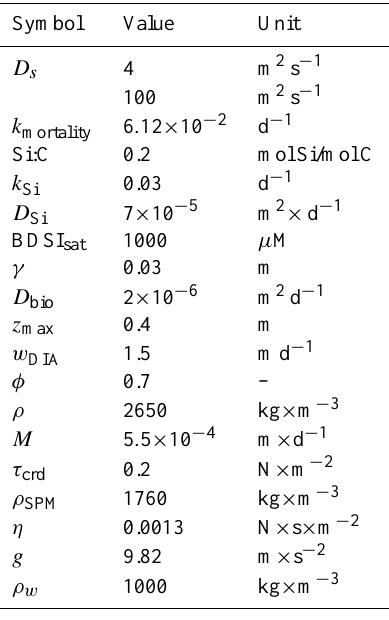
Table 1. Parameter values used in the model for primary production and silica consumption. See Vanderborght et al. (2006); Arndt et al. (2007) for parameter values of the complete reaction